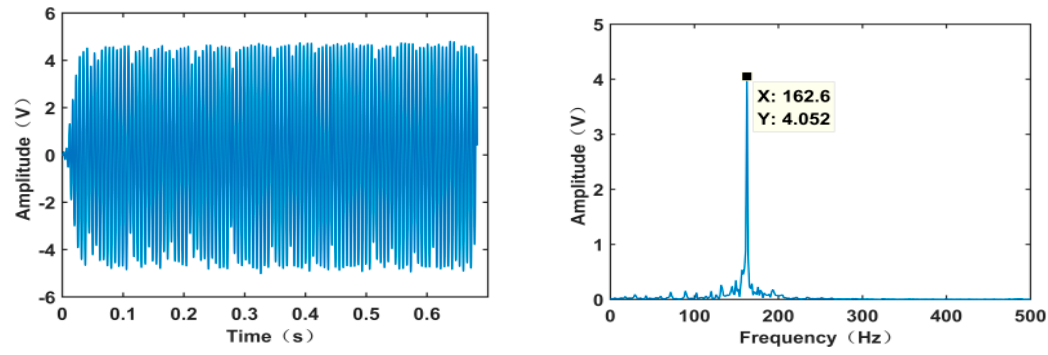
Figure 8. Inner race failure analysis.